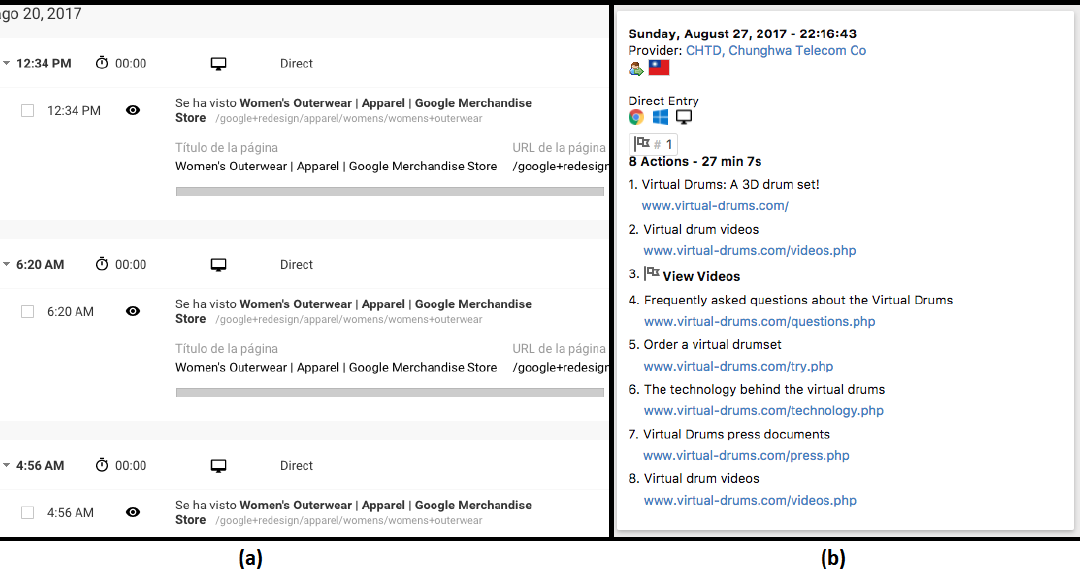
Figure 2. Browsing history reports by Google Analytics ( a ) and Matomo ( b ). Both are tables of the sequence in which a single visitor was browsing the site. ( a ) Screenshot of a GA user’s browsing history. ( b ) Screenshot of a Matomo user’s browsing